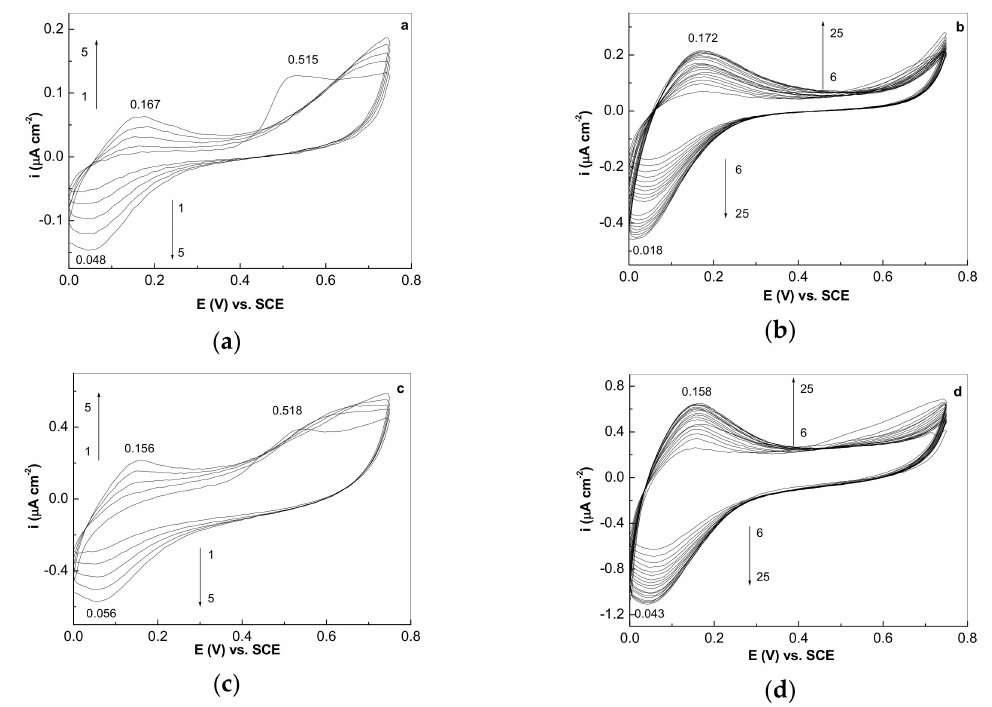
Figure 5. The first 1–5 and 6–25 cyclic voltammograms recorded during the electrochemical polymerization of 5 × 10 − 3 M 5A1N in the presence of 0.1 M HClO 4 and 10 − 3 M H 4 SiW 12 O 40 when the working electrode is the blank Au electrode ( a , b ) and the Au electrode is covered with the RGO sheets ( c , d ). The scan rate is equal to 50 mV s − 1